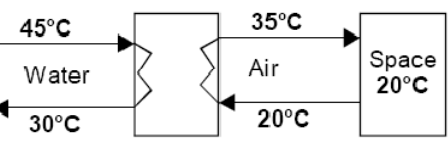
Figure 6. Space heating without isolation heat exchanger (modified from Rafferty [25]). Minimum acceptable supply water temperature = space temp. + 15 °C; Maximum available supply water temperature = geo. water temp. − 10 °C; Minimum achievable geo. leaving temperature = return air temp. + 10 °C.